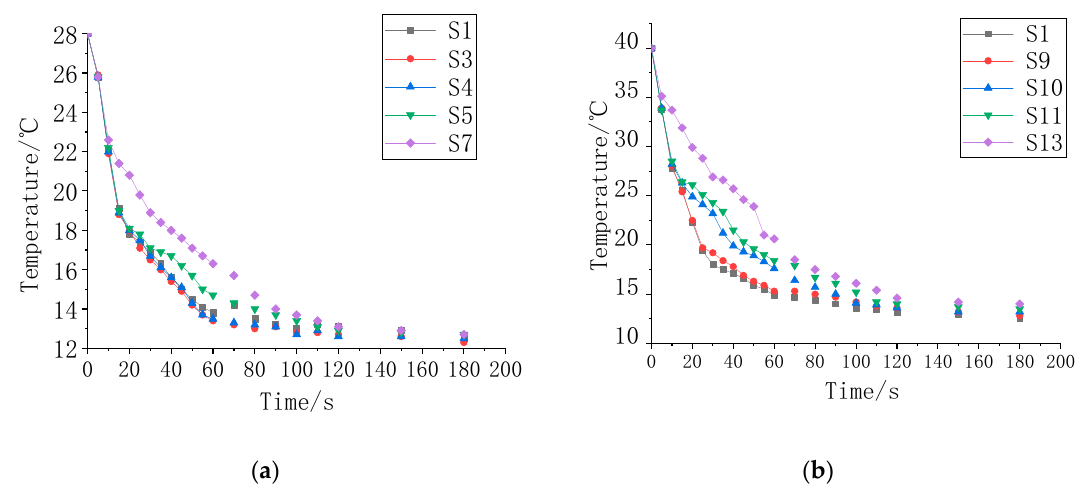
Figure 14. Temperature control performance of the composite coatings, (a) sample S1, S3, S4, S5 and S7; (b) sample S1, S9, S10, S11 and S13.